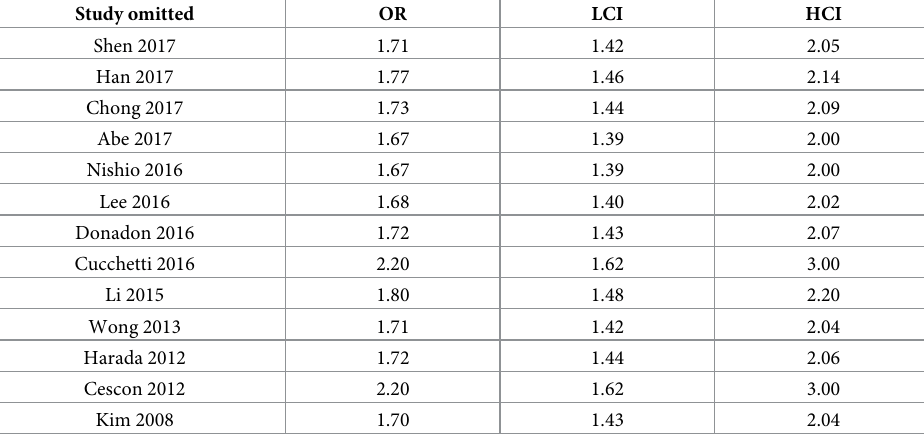
Table 5. Effect of individual studies on the pooled ORs of the prognostic value of liver stiffness measurement for overall postoperative